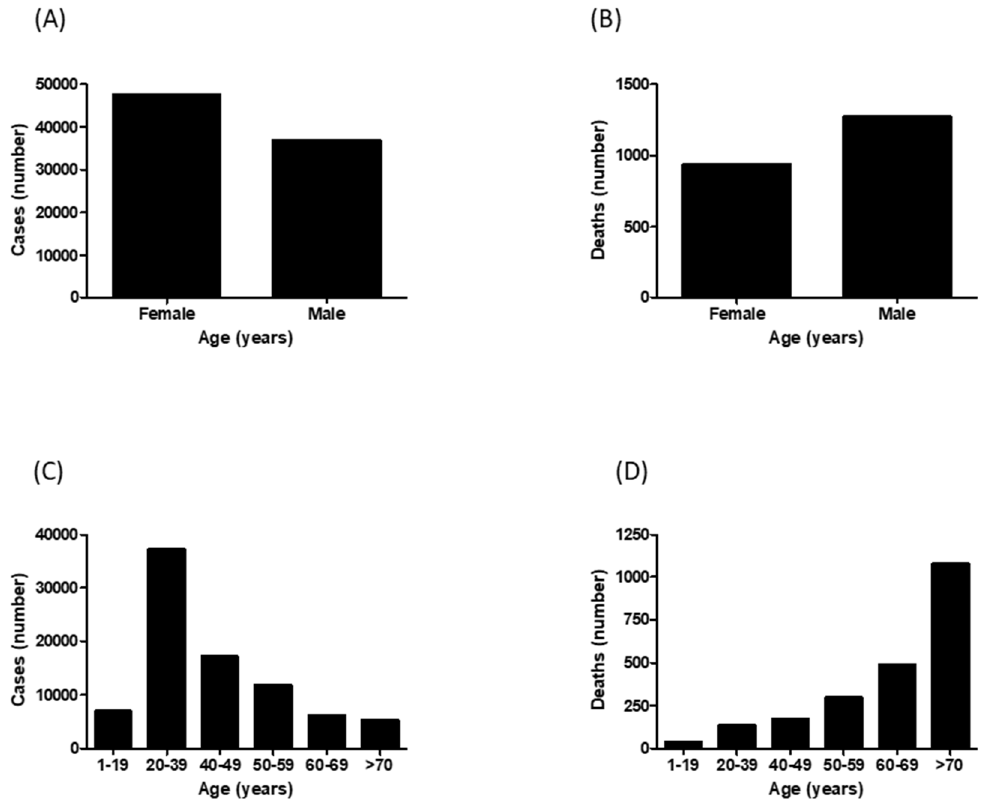
Figure 1. Demographic data of COVID-19 in the state of Sergipe (Brazil) from April to October 2020. ( A ) Distribution of cases between male and female. ( B ) Distribution of deaths between male and female. ( C ) Distribution of cases between different age ranges. ( D ) Distribution of deaths between different age ranges.